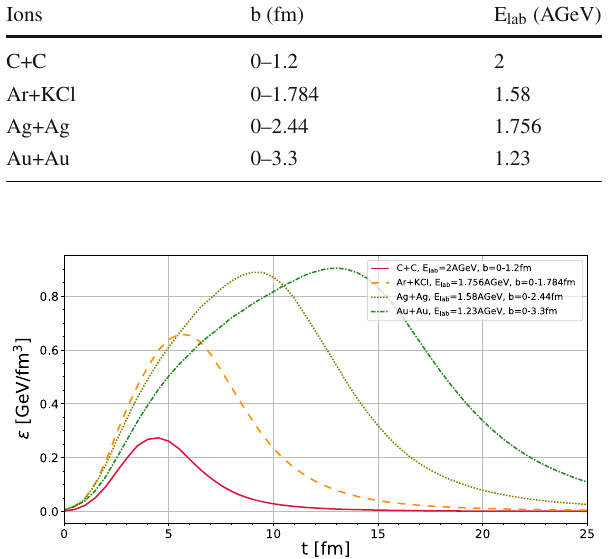
Fig. 7 Time evolution of the energy density in the center of the system for the reactions listed in Table